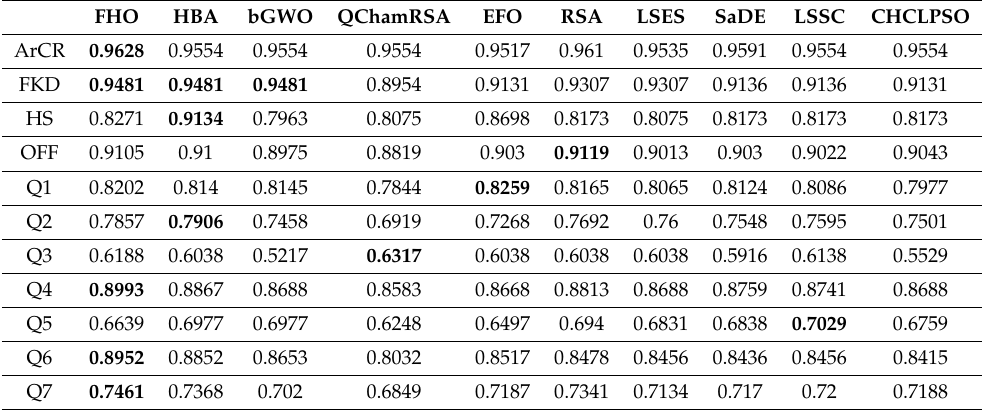
Figure 4. Average of the recall measure in the binary case. Table 7. F-measure results obtained by FHO and other methods in the binary